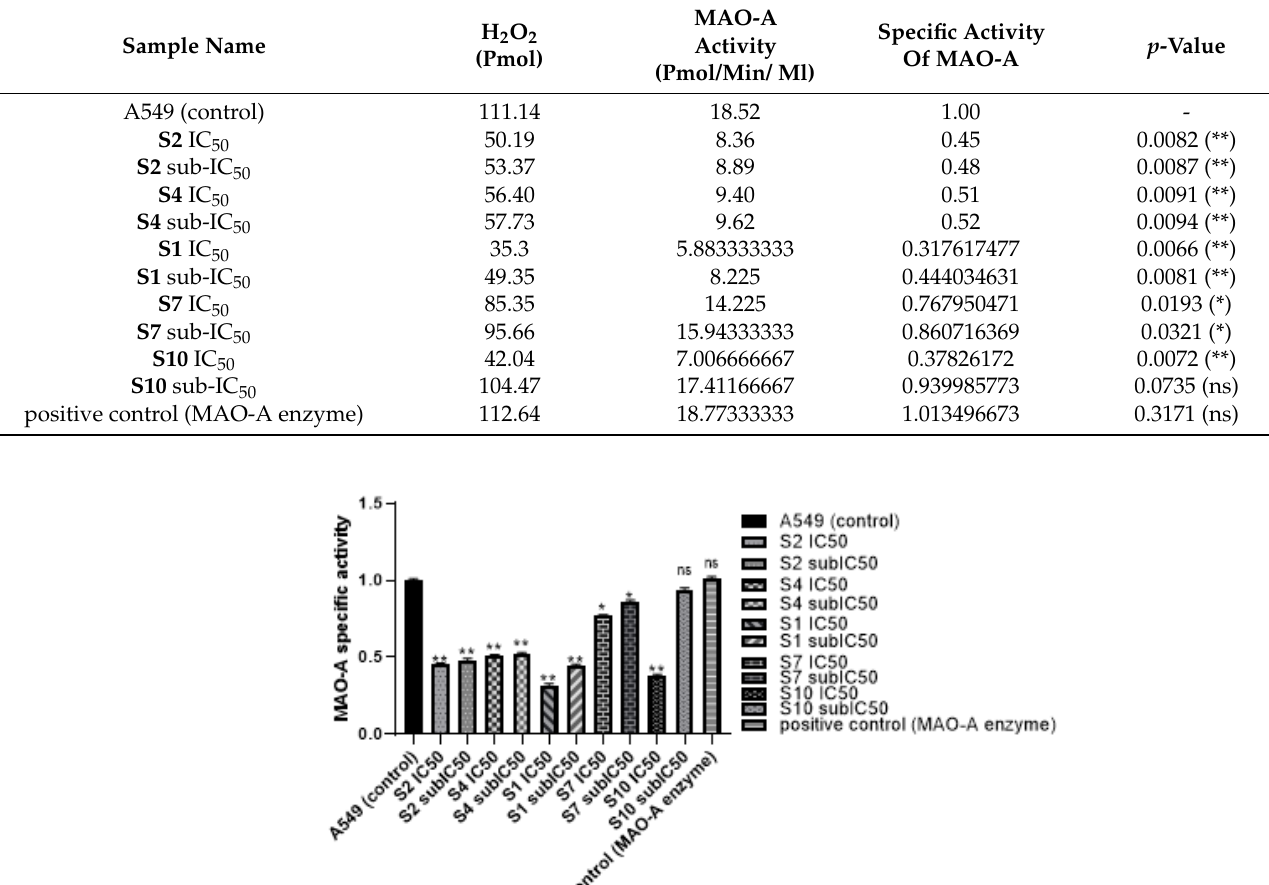
Table 3. MAO-A activity assay. A549 cells were cultured and treated with IC 50 , sub-IC 50 of S1 , S2 , S4 , S7 , and S10 . Fluorescence detection was on Ex/Em 535/587 nm. Data were expressed as mean and SD did not exceed 5%. p -value < 0.05 indicates statistical significance in-comparison to untreated control, while asterisk: ns (not-significant) p > 0.05; * p ≤ 0.05; ** p ≤ 0.01; *** p ≤ 0.001; **** p ≤ 0.0001 (according to GraphPad prism 9). µM: micromolar.